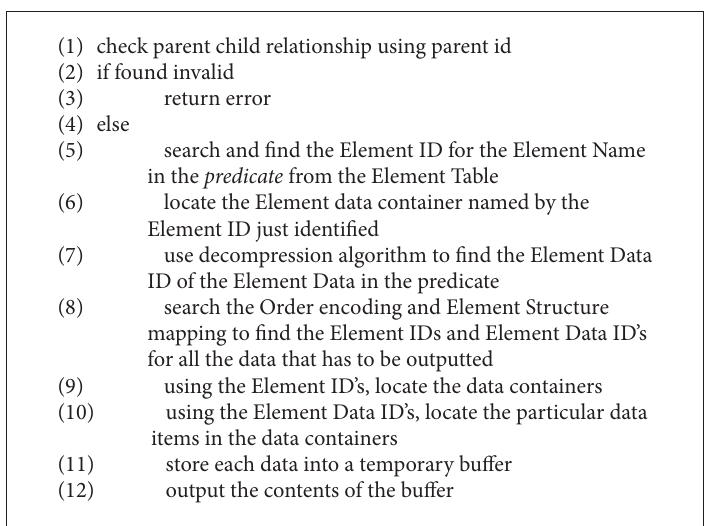
Algorithm 5: Conditional